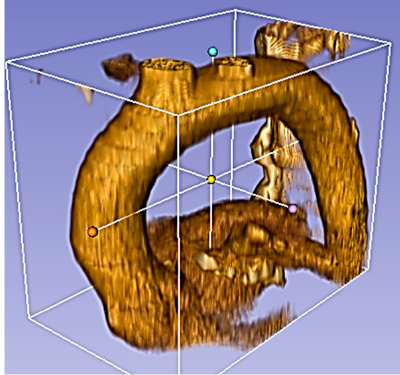
Figure 1. Physiological aorta root in the normal condition.